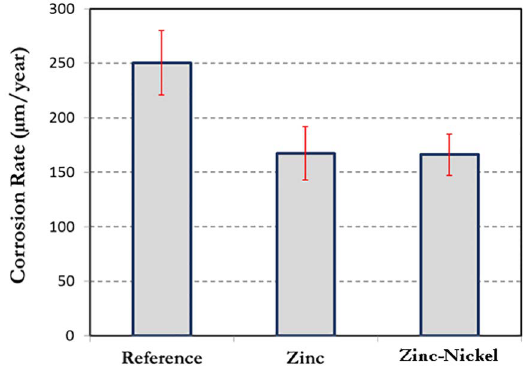
Figure 8. Corrosion rates of reference and coated rebars exposed to semi-cycles of partial immersion in 3 wt% NaCl and drying in a ventilated oven.